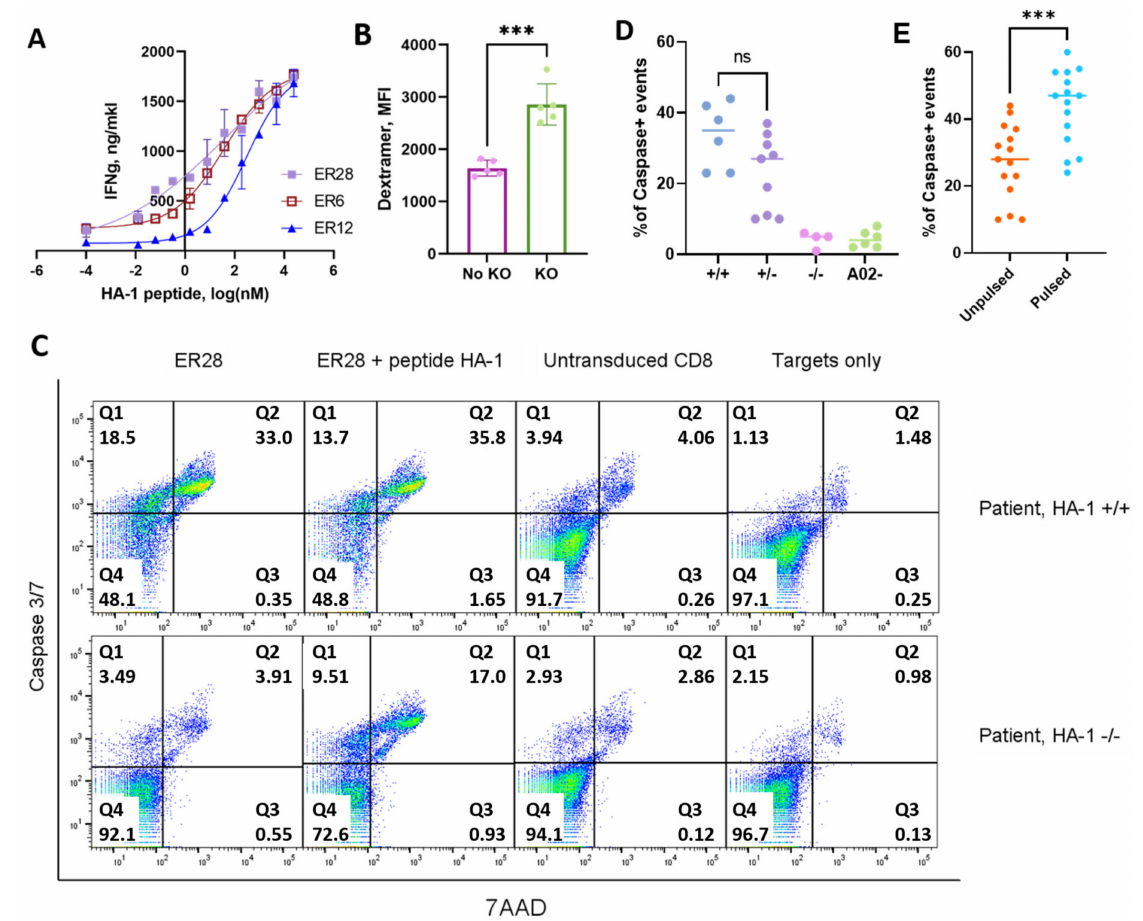
Figure 4. CD8 + T cells with murinized transgenic HA-1–specific TCRs and CRISPR/Cas knockout of endogenous TCR showed dose-dependent INF- γ response and specific lysis of PBMC from HA-1+ patients with various hematological malignancies. ( A ) CD8 + T cells modified with transgenic HA-1 specific TCRs stimulated by HLA-A*02 + K562 and exogenous HA-1 peptide. ( B ) The HA-1 HLA- A*02:01 dextramer staining of the CD8 + T lymphocytes transduced with HA-1 − specific TCR receptor ER28, without and with CRISPR/Cas9 knockout of endogenous TCR; the data for five donors is shown; bars represent mean absolute error. ( C ) PBMCs from leukemia patients were cultivated with the ER28 transgenic CD8 + T cells after endogenous TCR knockout. The ER28 transgenic CD8 + T cells were cultivated with PBMC pulsed with 4.88 nmol/mL of HA-1 peptide as a positive control. The mock-transduced (PBS) CD8 + T cells were used as a negative control. The patient PBMC cultured without effectors were used as control of background cell death. Plots of caspase 3/7 and 7AAD staining are shown for two representative patients. ( D ) The ER28 transgenic CD8 + T cells demonstrate specific lysis of the PBMC from HA-1 + patients. No cytotoxicity to the cells of HA-1 − and HLA- A*02 − donors were observed. Each dot represents the mean percentage of the Caspase/7AAD positive events observed by flow cytometry analysis of two independent cultures of CD8 + T cells from two different donors. ( E ) Transgenic CD8 + T cells demonstrate a higher level of cell killing when exogenous HA-1 peptide was added compared to samples where only endogenously processed peptide was present. Statistical significance: unpaired t -test *** p <